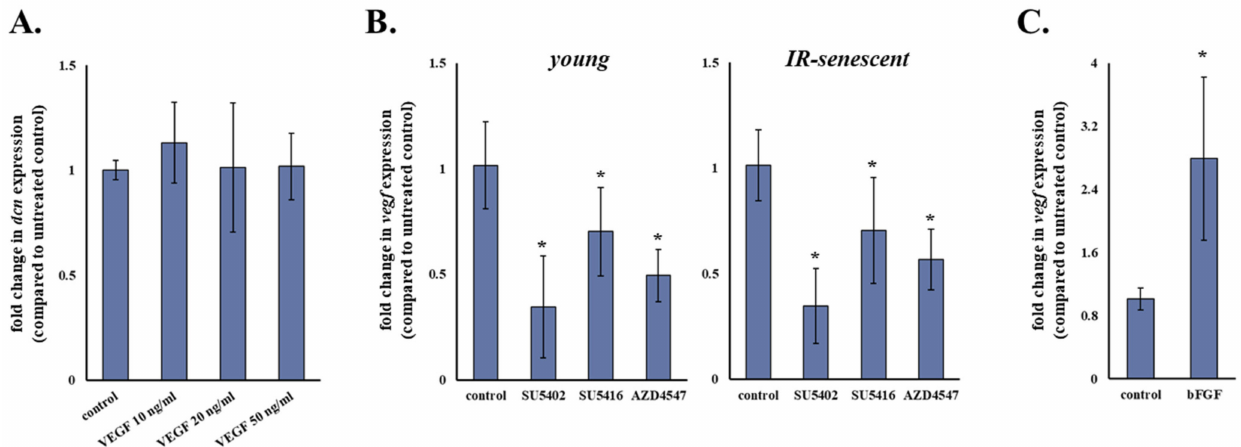
Figure 5. VEGF participation in the regulation of decorin expression in human breast stromal fibroblasts. Human breast stromal fibroblasts were serum starved for 24 h and then treated with VEGF (10, 20 and 50 ng/mL) ( A ), were exposed to 20 µ M of the FGFR and VEGFR inhibitor SU5402, 1 µ M of the VEGFR inhibitor SU5416 and 21 nM of the FGFR inhibitor AZD4547 ( B ) or were serum starved for 24 h and then treated with bFGF (10 ng/mL) ( C ) for 24 h before RNA extraction, first-strand cDNA synthesis and real-time PCR analysis with glyceraldehyde-3-phosphate dehydrogenase (GAPDH) serving as the reference gene. Relative mRNA levels compared to the respective untreated control are presented as means ± standard deviations of three experiments. Statistically significant differences in comparison to the respective control without the inhibitor are designated by asterisks (*) (Student’s t test, p < 0.05). IR: ionizing radiation.